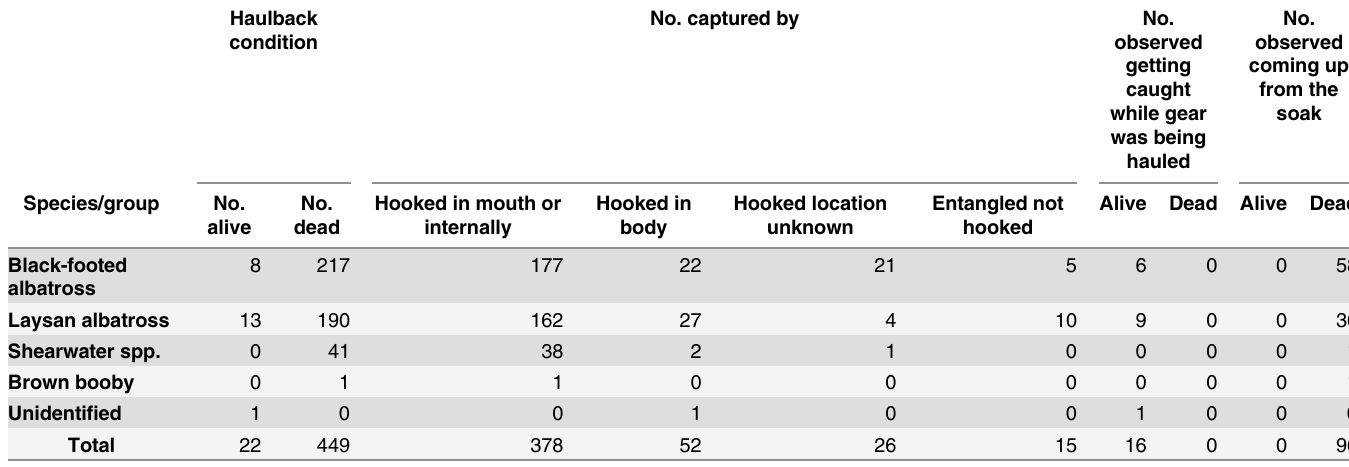
Table 3. Seabird haulback condition, number caught by anatomical location of hook or by entanglement but not also hooked, number observed captured while gear was being retrieved and their haulback condition, and number observed coming up on the gear from the soak and their haul- back condition, observer program data, Hawaii deep-set pelagic longline tuna fishery, 17 October 2004 to 19 May 2014. Haulback No. captured by condition